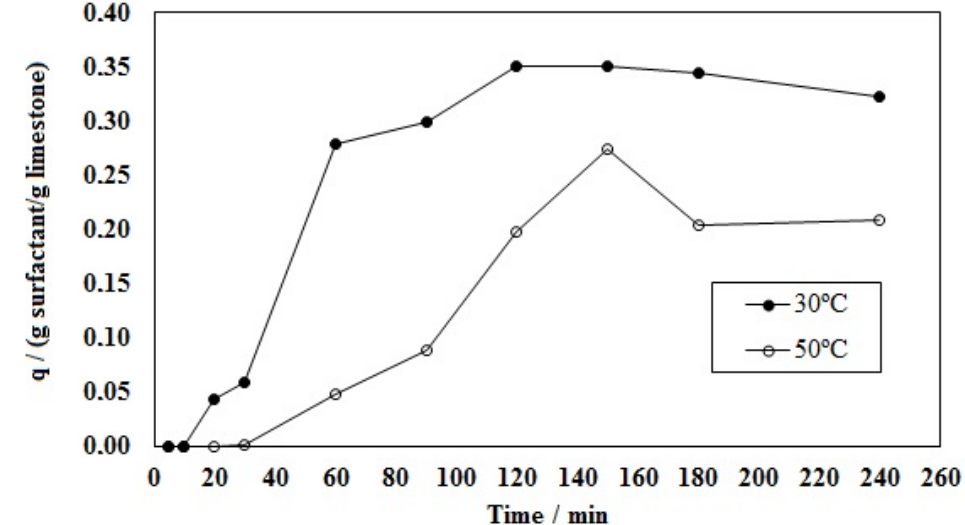
Figure 4. Adsorption capacity as a function of contact time for the SCO solution at 30 ºC and 50